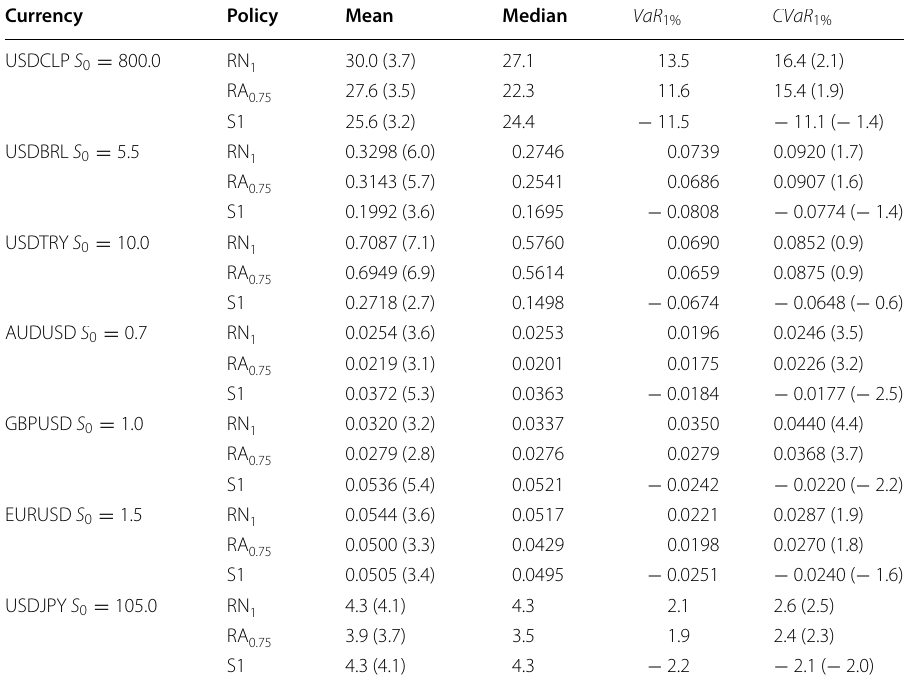
The numbers in parenthesis are the P&L divided by S 0 , that is, the P&L in terms of the foreign currency (US dollar cents for USDCLP, USDBRL, USDTRY, USDJPY, pennies for GBPUSD, euro cents for EURUSD, Australian dollar cents for AUDUSD). We set 2.5% and D π u π d L 1 = = = =